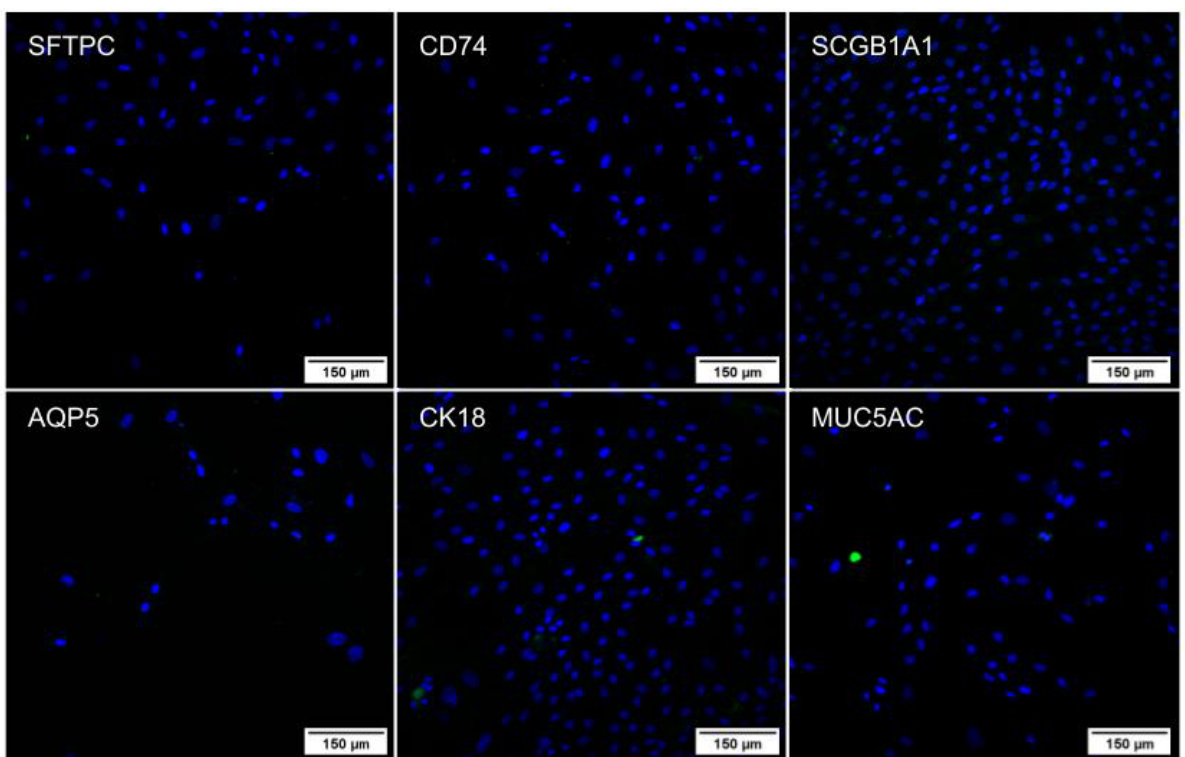
Figure 4. Immunocytochemistry of lung cells (sample C6) with DAPI labeling the nuclei in blue and FITC marking specific proteins in green. Images obtained using a high-throughput microscope In Cell Analyzer 2000 (GE Healthcare ® , Chicago, IL, USA).